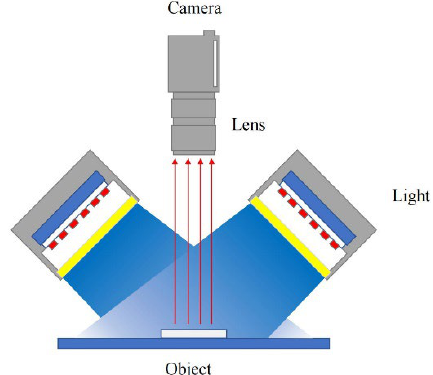
Figure 5. 45 ◦ blue bar light source. Figure 5. 45° blue bar light source. Figure 5. 45° blue bar light source.